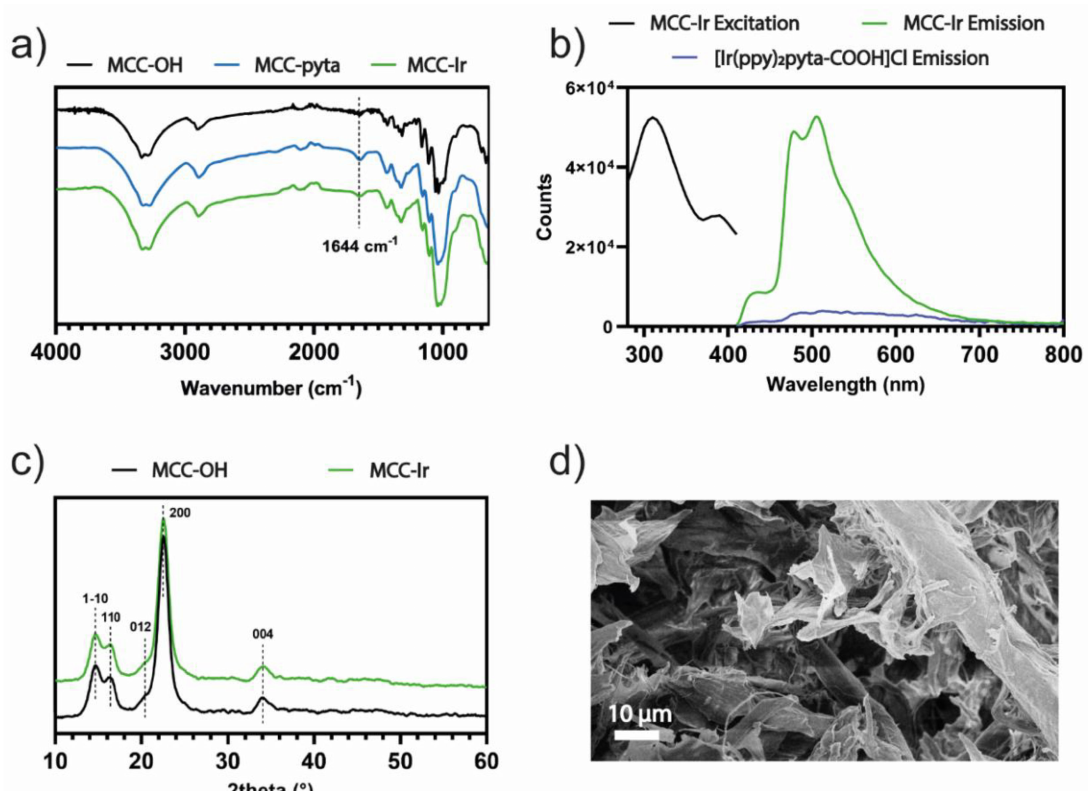
Figure 2. Spectroscopic and microscopic characterization of synthetic materials. ( a ) ATR-FTIR spectra of MCC-OH, MCC-pyta, and MCC-Ir. ( b ) Solid-state phosphorescence studies. For both MCC-Ir and [Ir(ppy) 2 (pyta-COOH)]Cl emission spectra, the excitation wavelength was 310 nm and the slits were set at 2 nm for both excitation and emission beams. For the excitation spectrum of MCC-Ir, the emission intensity at 508 nm was recorded by varying the excitation wavelength from 280 to 410 nm and the slits were set at 2 nm for both excitation and emission beams. ( c ) Powder XRD spectra of MCC-OH and MCC-Ir. The Miller indices attributed to the MCC’s X-ray reflections are reported above each peak. ( d ) Scanning electron microscopy (SEM) image of